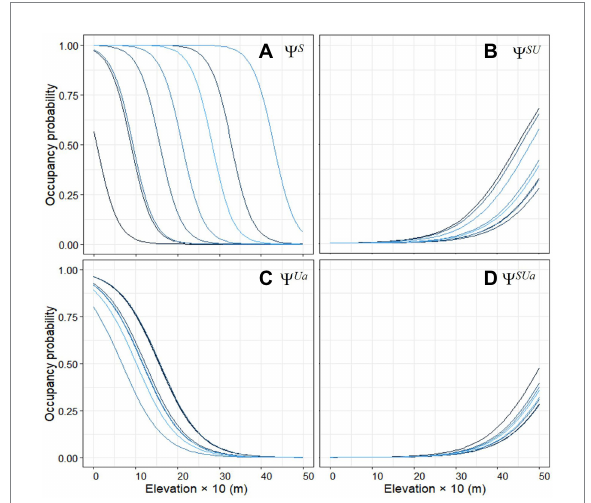
FIGURE 5 Empirical Bayes plots of the marginal occupancy probability of (A) non-native smallmouth bass present, (B) native Umpqua chub present/ bass present, (C) native Umpqua chub abundant/ non- native bass not present, and (D) native Umpqua chub abundant/ non-native bass present, with elevation during 2006–2021 snorkel surveys. Each colored line represents a different watershed in the Umpqua basin, Oregon, United